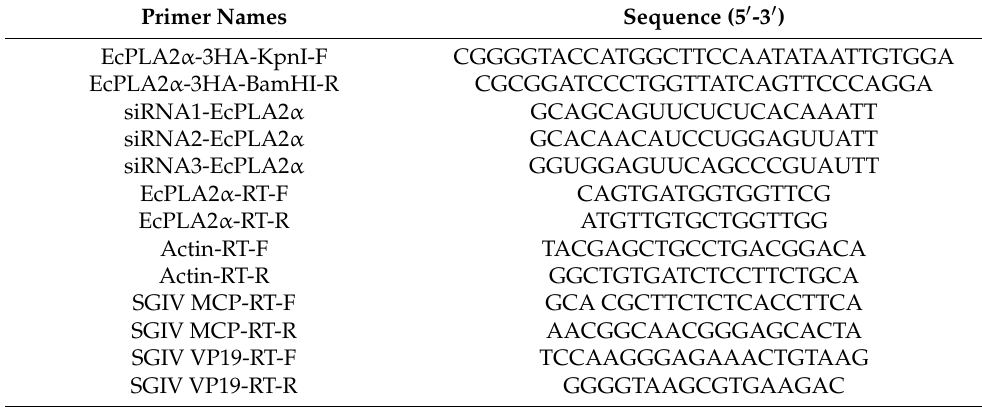
Table 1. Primers used in this